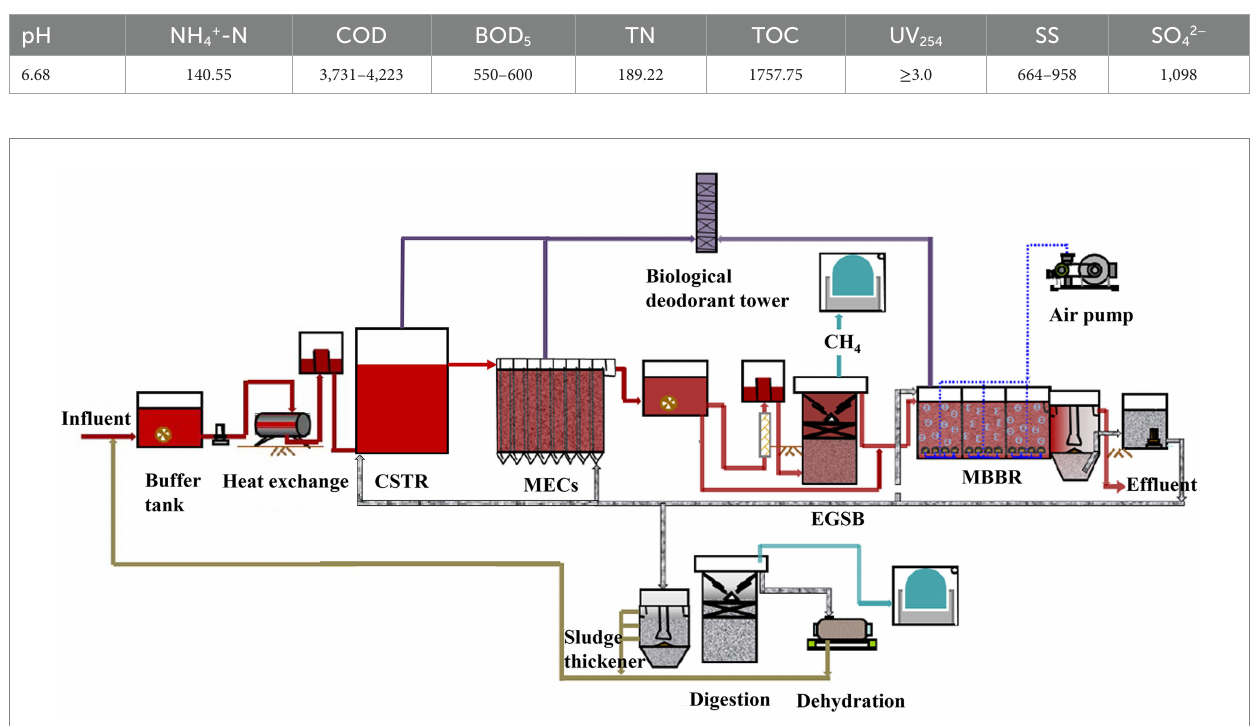
TABLE 1 Water quality parameters of pharmaceutical factory wastewater (unit: mg/L).